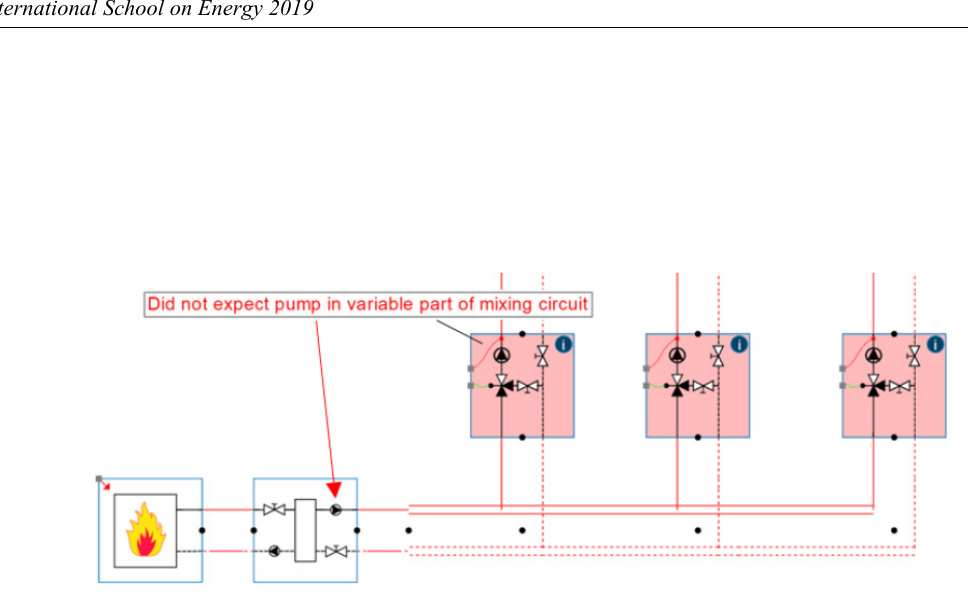
Fig. 22. – Design faults are signalled automatically and a textual instruction is